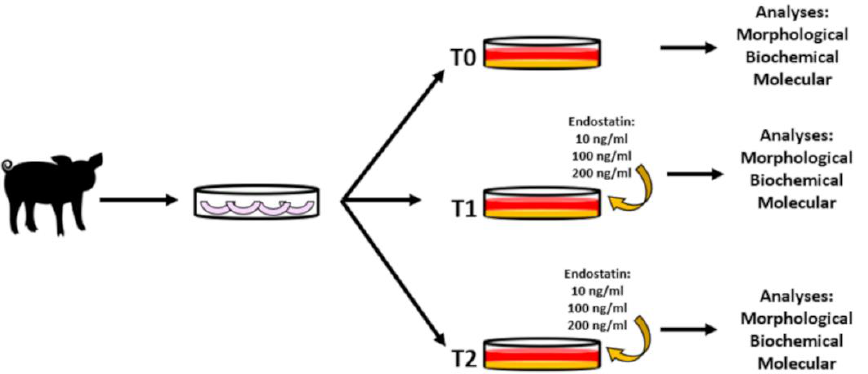
Figure 1. Experimental design. Meniscal cells were isolated and expanded to P3. At this passage, the fibrin glue hydrogel was assembled and the cells were added. Scaffolds were cultured in different concentrations of exogenous endostatin (10 ng/mL, 100 ng/mL, 200 ng/mL) and in negative control conditions by means of no endostatin added. After 9 or 21 days in vitro , the scaffolds were collected for morphological, biochemical, and molecular analysis.